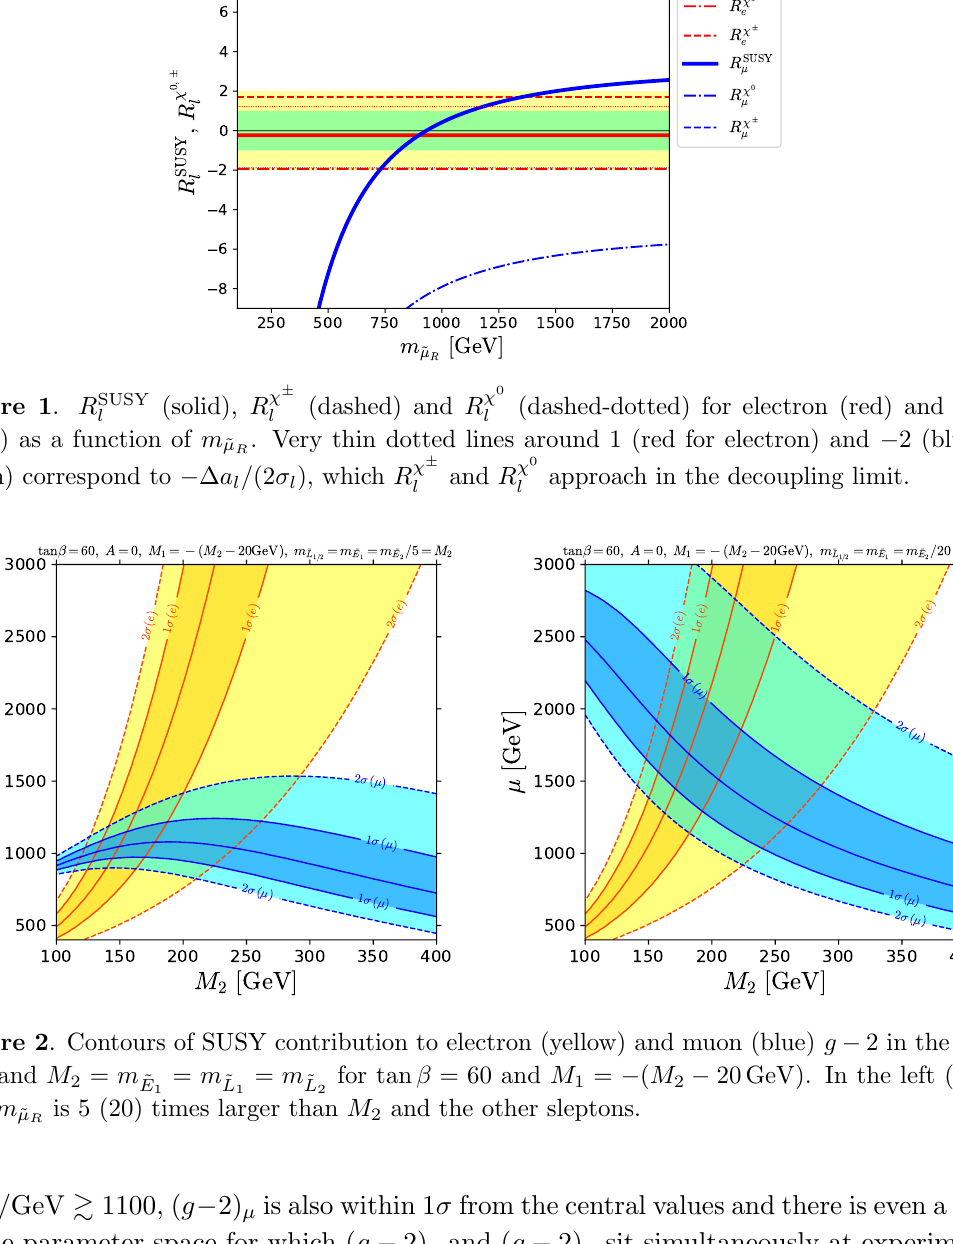
m = GeV & 1100, ( g (cid:0) 2) e (cid:22) R in the parameter space for which ( g (cid:0) 2) central